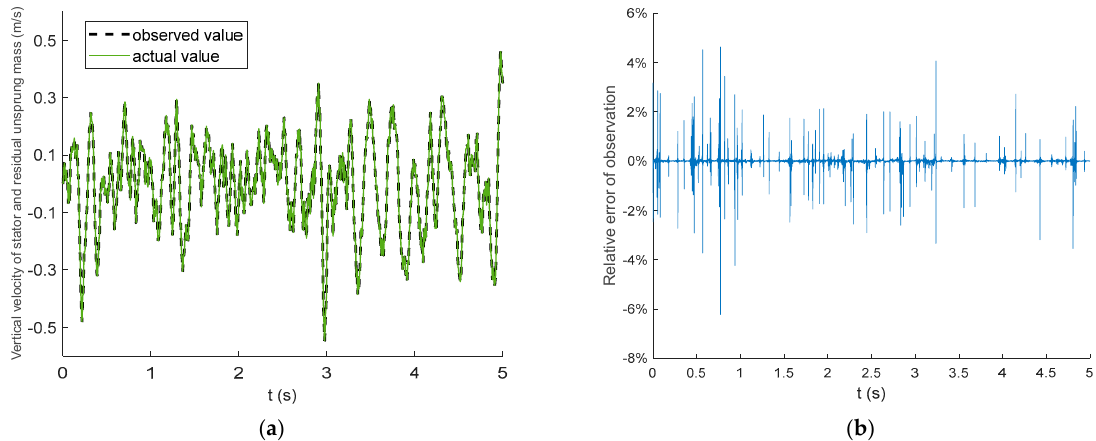
Figure 8. Observed results of vertical velocity of stator and residual unsprung mass. ( a ) Comparison of observed and actual values. ( b ) Relative error between observed and actual values.